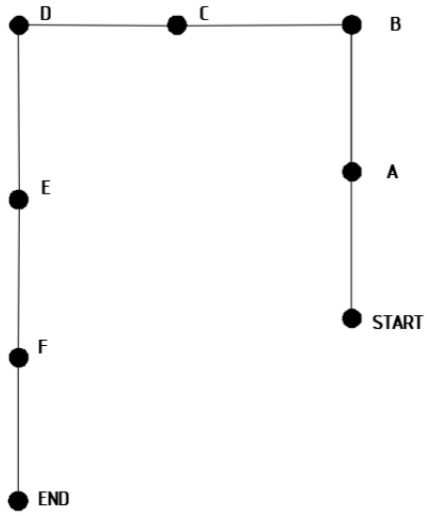
Figure 20. Reference trajectory in the test case. Electronics 2019 , 8 , 200